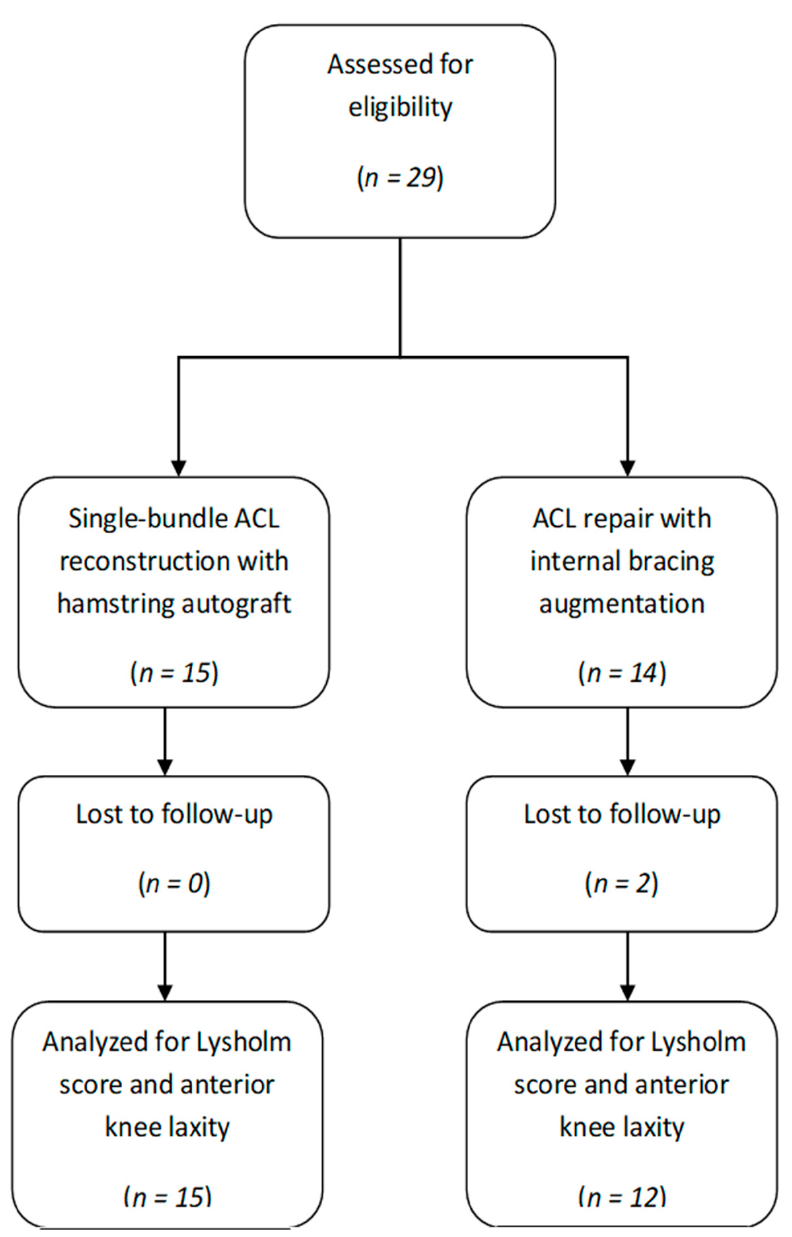
Figure 1. The flowchart presenting the study design.